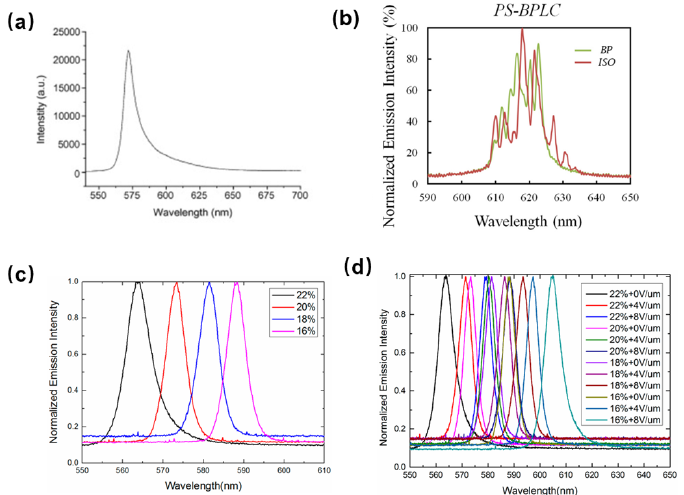
Figure 5. ( a ) Emission spectrum of R6G in 20 wt% (E ‐ CE) C/AA. Reprinted with permission from Ref. [74]. Copyright 2008 Elsevier. ( b ) Emission spectra of PS ‐ BPLC systems in different phases. Reprinted with permission from Ref. [75]. Copyright 2012 The Optical Society. ( c ) Emission spectra of templated SPLC systems with different concentrations of the polymer; ( d ) emission spectra of the templated SPLC systems under different electric fields. Reproduced from Ref. [11]. MDPI, 2017.